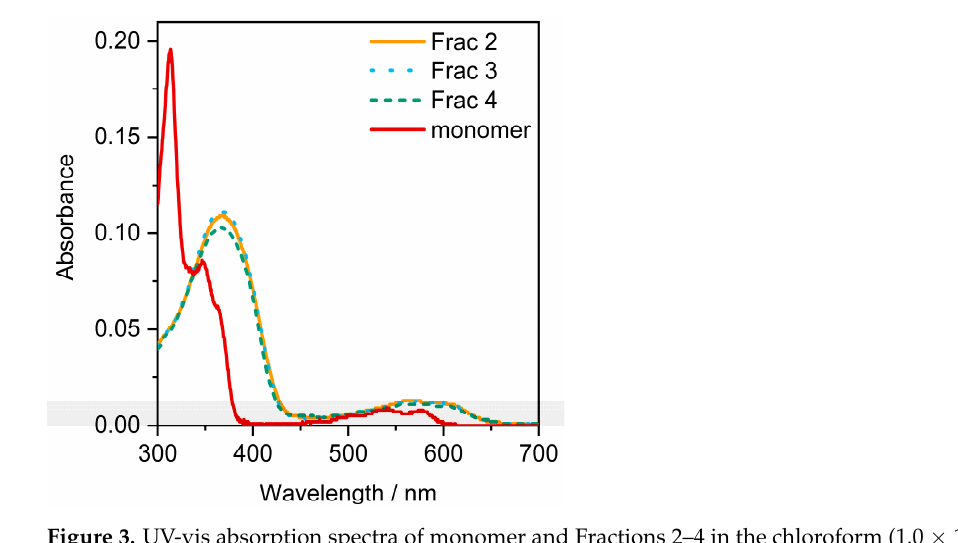
5AP monomer and homopolymer. Figure S6: 1 H NMR spectra of monomer and the fractionated samples (aromatic region, measured in CD 2 Cl 2 ). Table S1. Screening of the reaction conditions for homopolymerization via oxidative coupling.